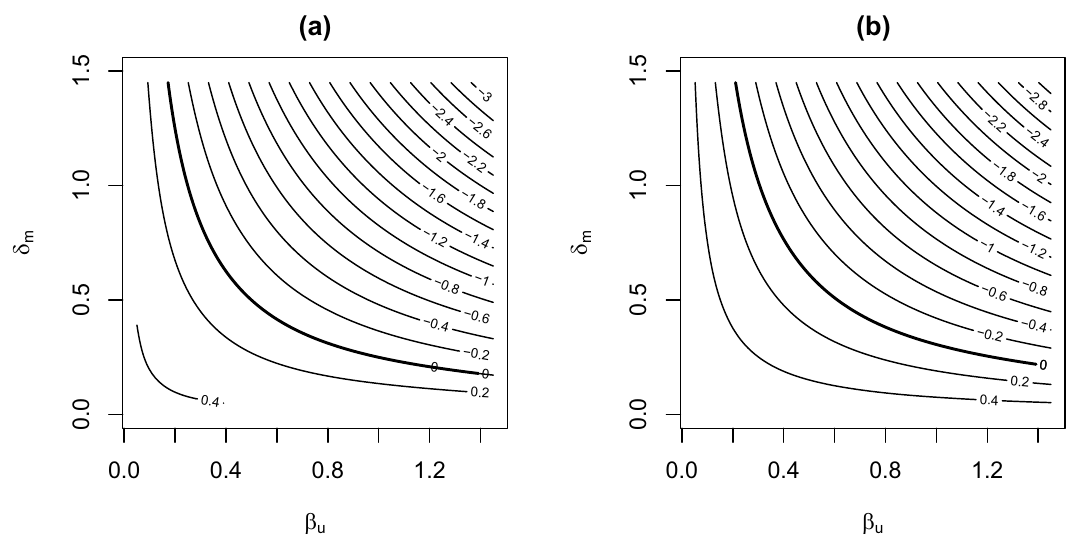
Figure 2: Sensitivity contour plots using regression coe ffi cients. ( a ) Disparity reduction. ( b ) Disparity remaining. Note. ( 1 ) Bold lines represent the points at which the estimates become zero. ( 2 ) Standard lines represent the points at which the estimates become the respective value ( e.g., 0.4, 0.2, −0.2, −0.4 )